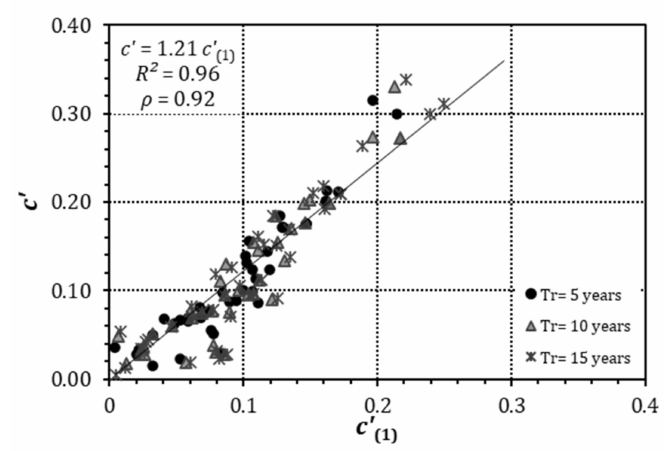
Figure 4. Regressive equation for the parameters c (1) and c (cid:48)